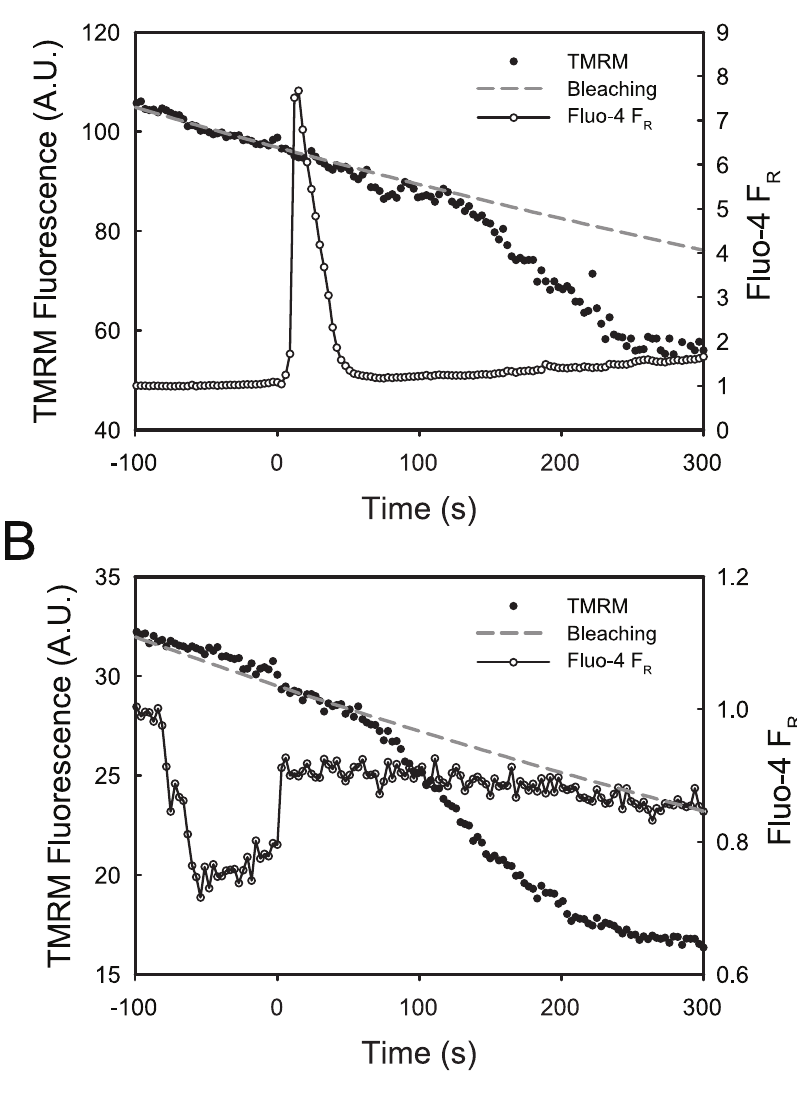
Figure 2. Air bubble contact causes a loss of mitochondrial membrane potential. Representative traces of fluorescence signals obtained from HUVEC loaded with DY m indicator TMRM (left axis, solid circles) and intracellular calcium dye Fluo-4 (right axis, open circles) responding to air bubble contact at t=0. Panel A was recorded under control conditions, while panel B was recorded in the presence of the TRPV channel blocker ruthenium red (1 m mol/L). Dashed grey line represents the expected exponential decay of the TMRM signal due to